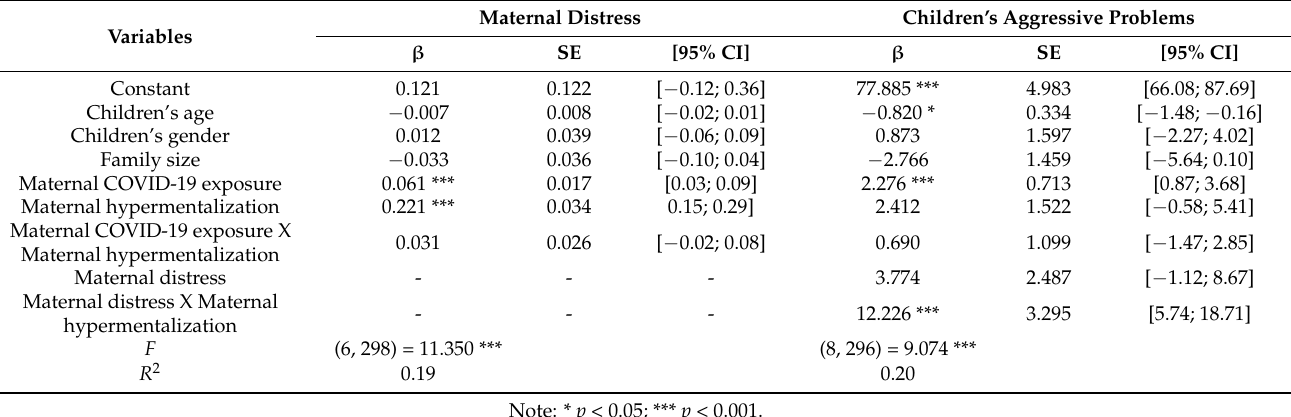
Table 4. Moderated Mediation Model—Model 3.